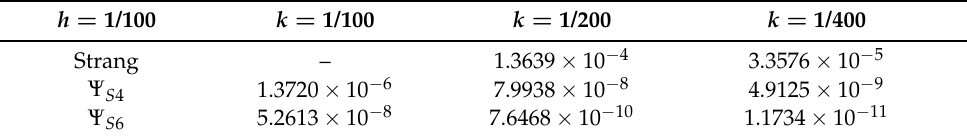
( error ( k ) /error ( k /2 )) for three symmetric-splitting methods with h = 1/100. Table 4. Evolution of log 2 h = 1/100 k = 1/100 k = 1/200 Strang